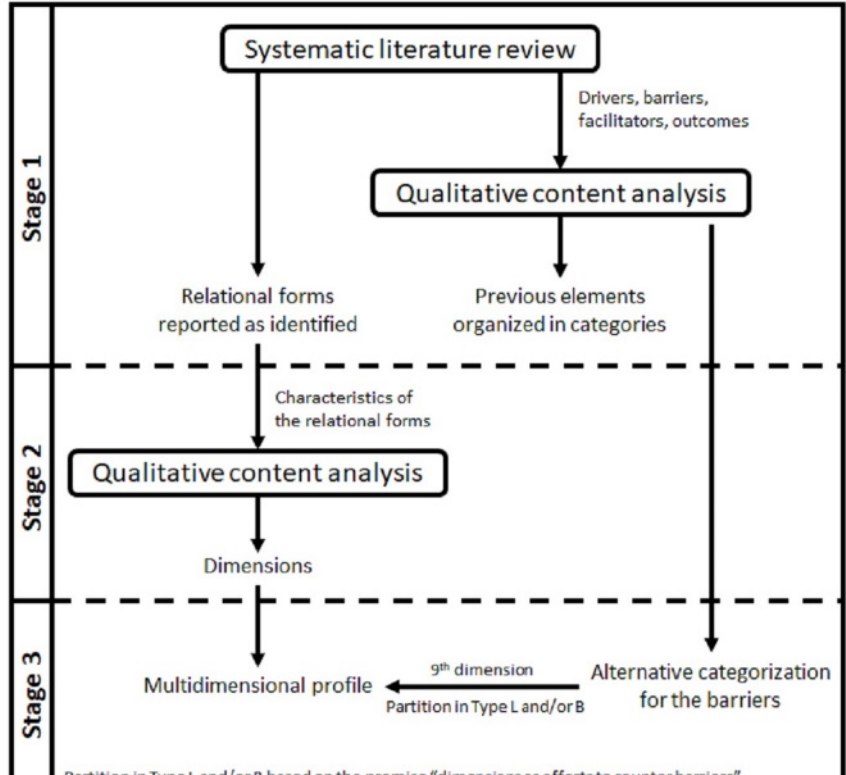
Figure 1. Overview of the methods used in each stage.